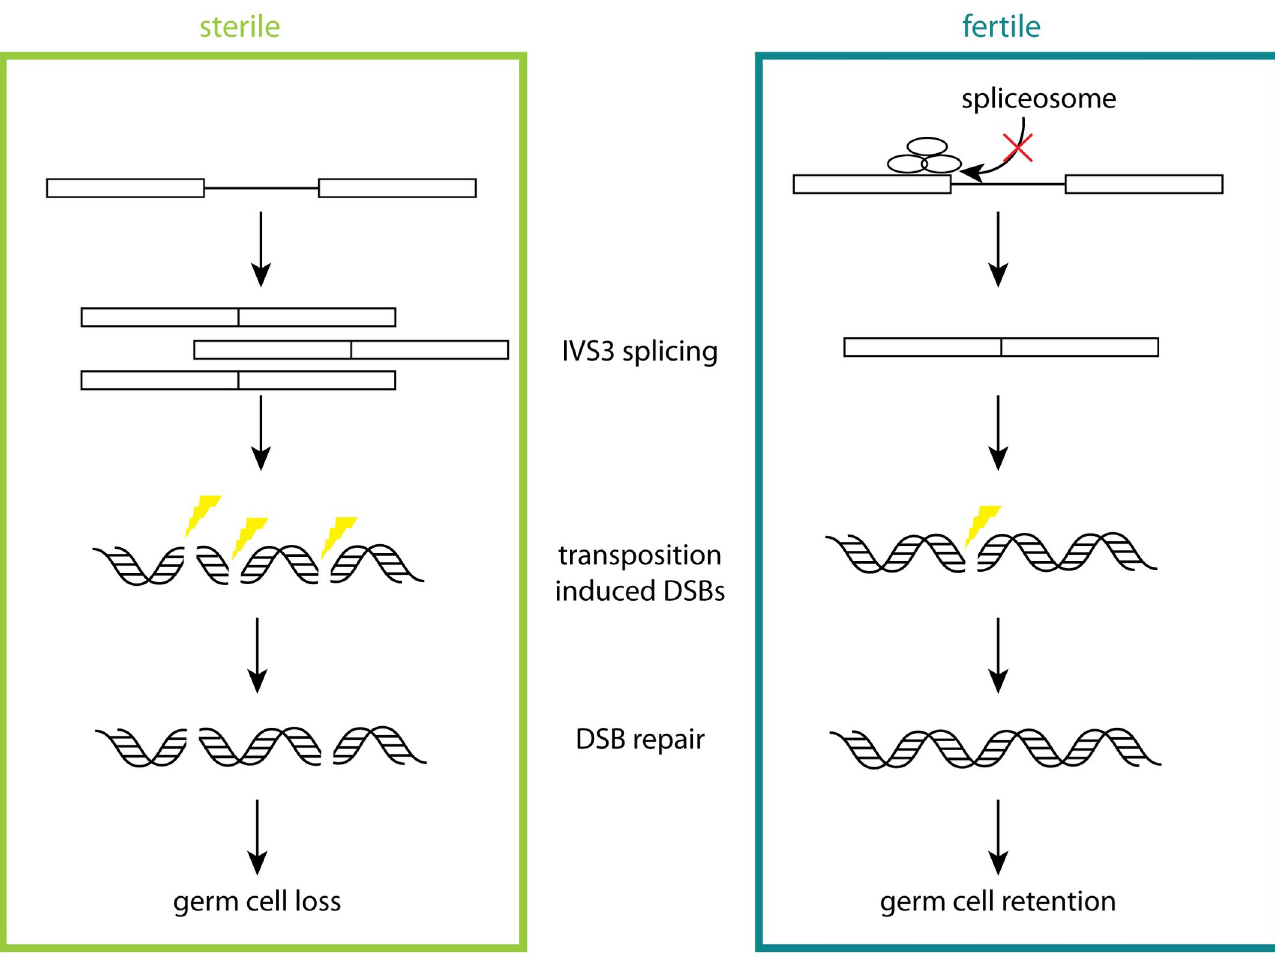
Fig 7. Schematic of phenotypic differences between sterile and fertile alleles. Differences in sterile and fertile alleles between IVS3 splicing and DNA repair are represented. In fertile alleles, host splicing suppressor expression is increased, leading to reduced production of spliced P-transposase encoding transcripts. As a consequence of reduced transposase production, it is predicted that fewer DSBs are produced in dysgenic females. However, it is also predicted that those breaks that are produced are repaired more efficiently.